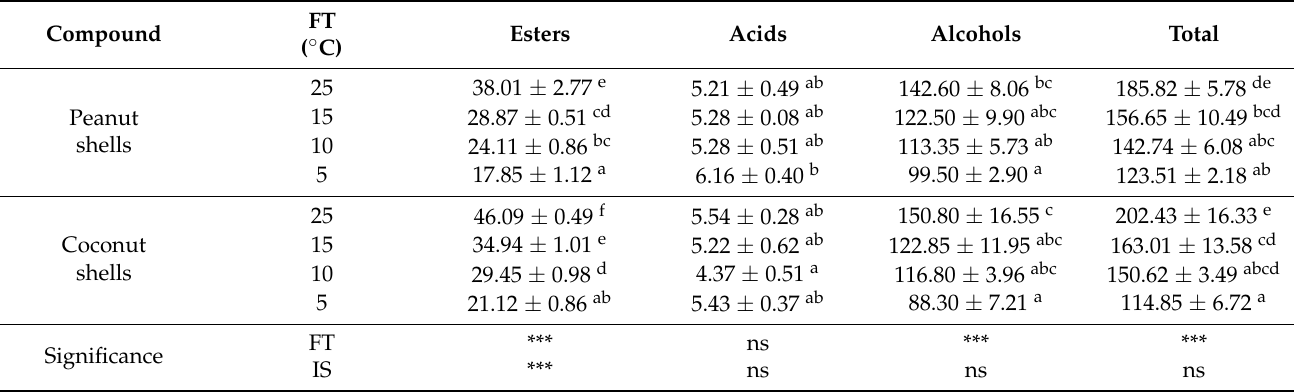
Table 3. Effect of fermentation temperature on volatile compounds (mg L − 1 ) of beers produced with thermally dried immobilized S. cerevisiae on peanut shells and coconut shells.